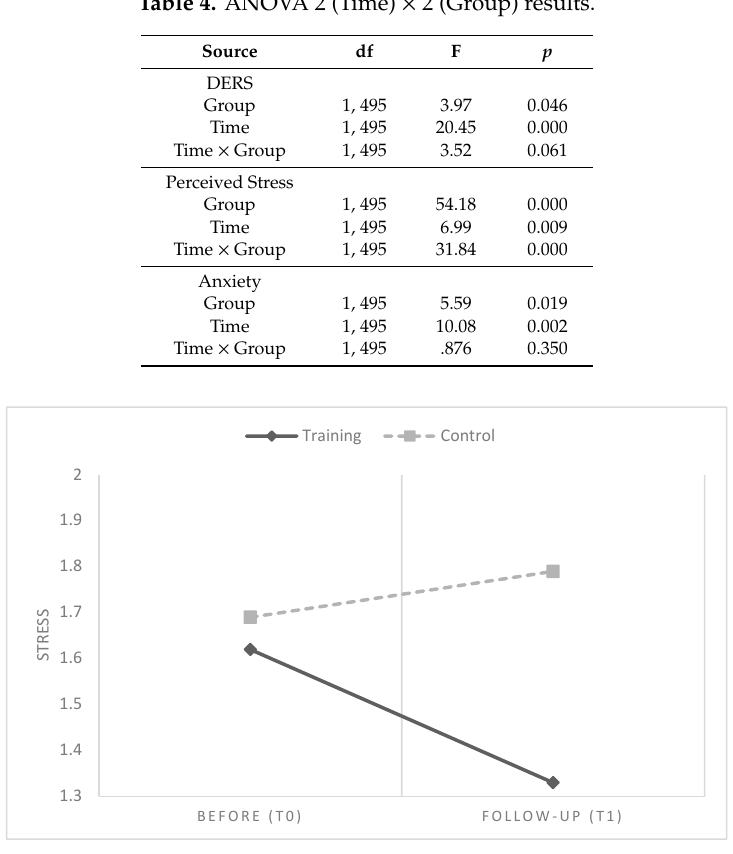
Figure 2. Mean di ff erences between groups and time in perceived stress. Figure 2. Mean differences between groups and time in perceived stress. Figure 2. Mean differences between groups and time in perceived stress.